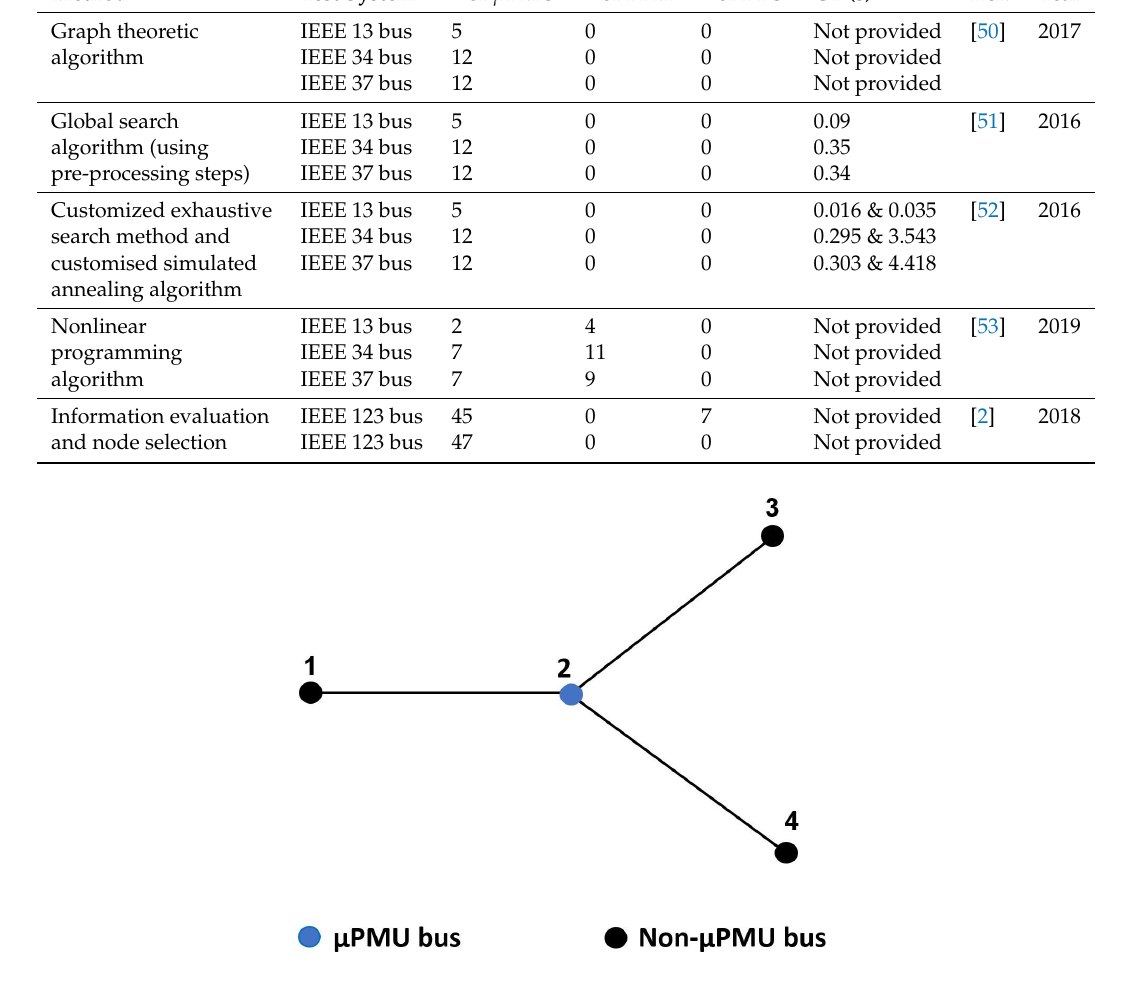
Figure 6. Example four-node